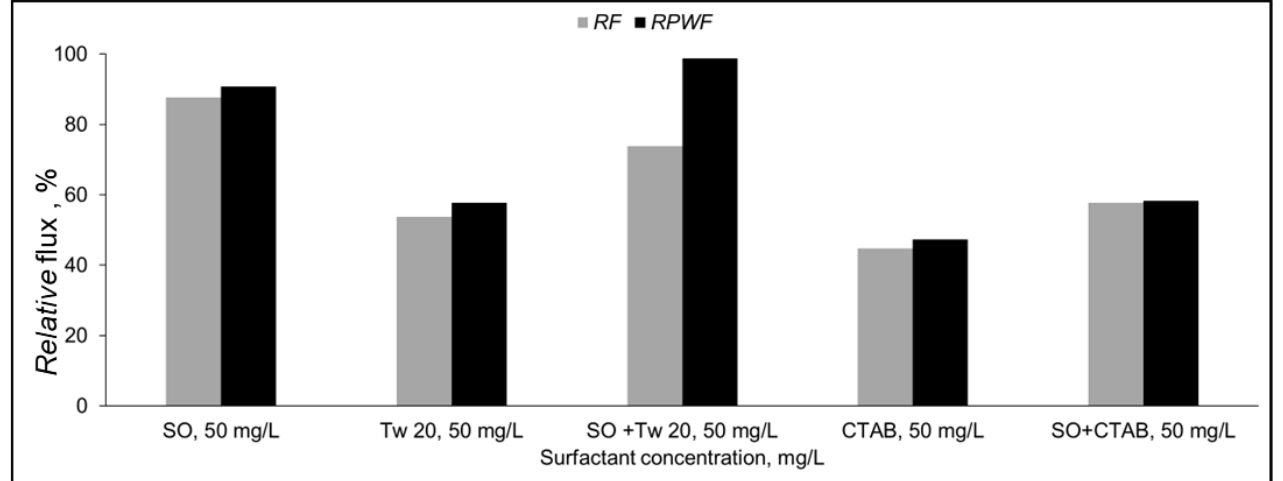
Figure 8. Relative flux (RF ) and Relative pure water flux (RPWF) of PA membrane for 50 mg/L surfactant mixture (10% recovery ratio, TMP = 1.5 MPa, T = 25 °C).